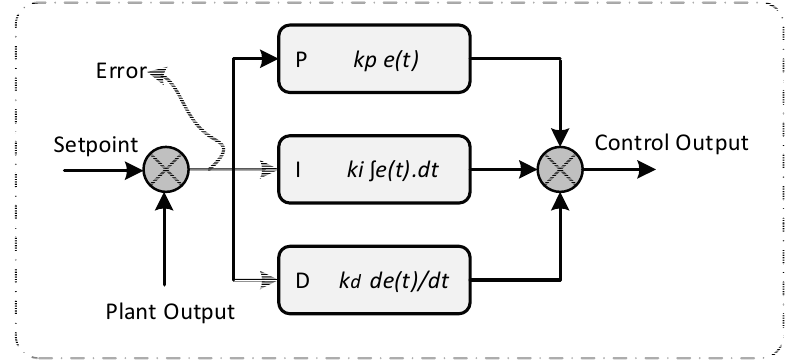
Figure 1. Block diagram of typical PID control structure.